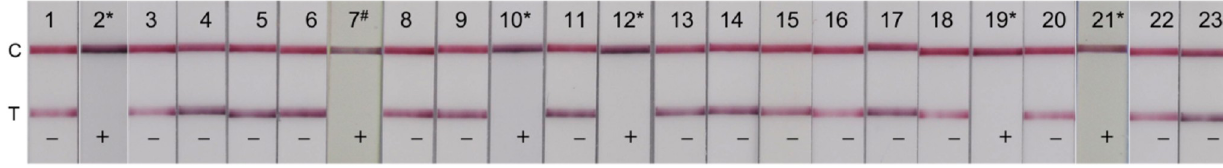
Fig 6. LFIA results from mushroom extracts. The mushrooms are as follows: 1) Amanita augusta , 2) A . bisporigera � , 3) A . calyptratoides , 4) A . constricta , 5) A . gemmata , 6) A . magniverrucata , 7) A . marmorata # , 8) A . muscaria , 9) A . novinupta , 10) A . ocreata � , 11) A . pantherina , 12) A . phalloides � , 13) A . protecta , 14) A . velosa , 15) Agaricus californicus , 16) Ag . xanthodermus , 17) Boletus edulis , 18) Cantharellus californicus , 19) Galerina marginata � , 20) G . sideroides , 21) Lepiota subincarnata � , 22) Pholiotina utricystidiata , and 23) Volvariella volvacea . Those marked with an � were confirmed by LC-MS analysis to contain α -AMA, and the sample marked with a # was confirmed by LC-MS analysis to contain phallotoxins. 74 additional mushroom species tested were negative by LFIA. Names of all mushrooms tested are provided in Table 2.